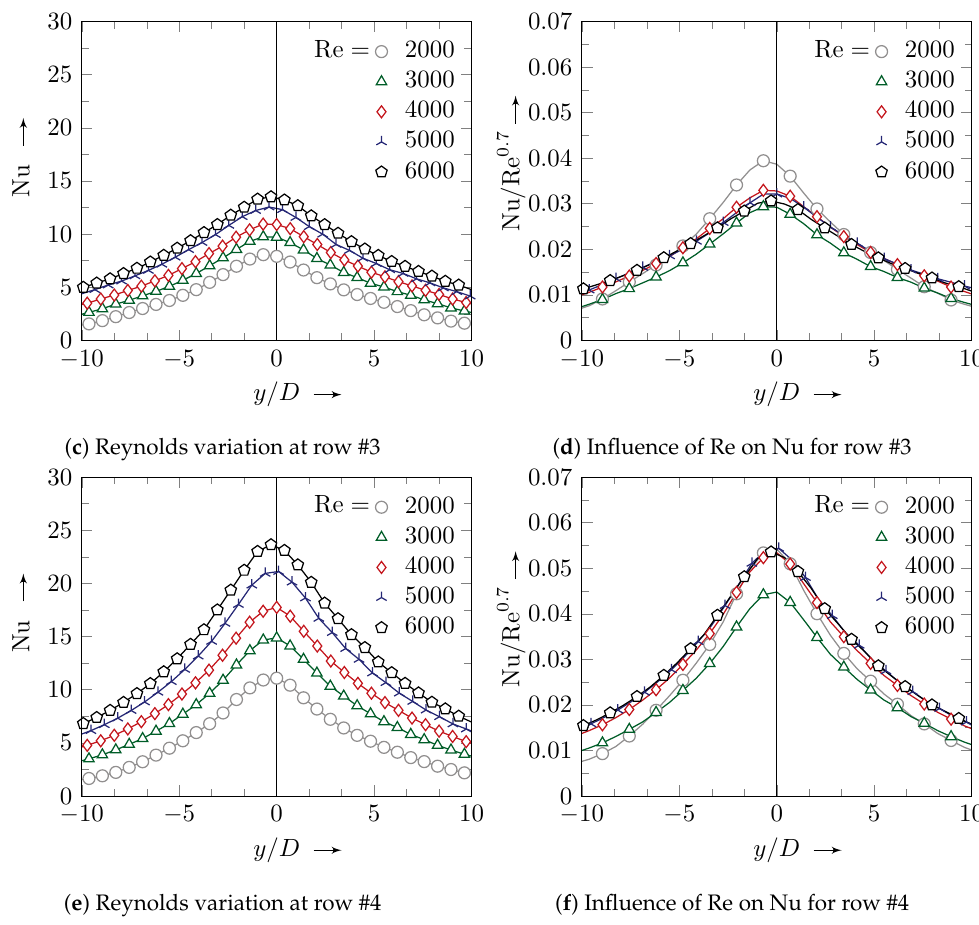
Figure 10. Comparison of the heat transfer characteristics at different Reynolds